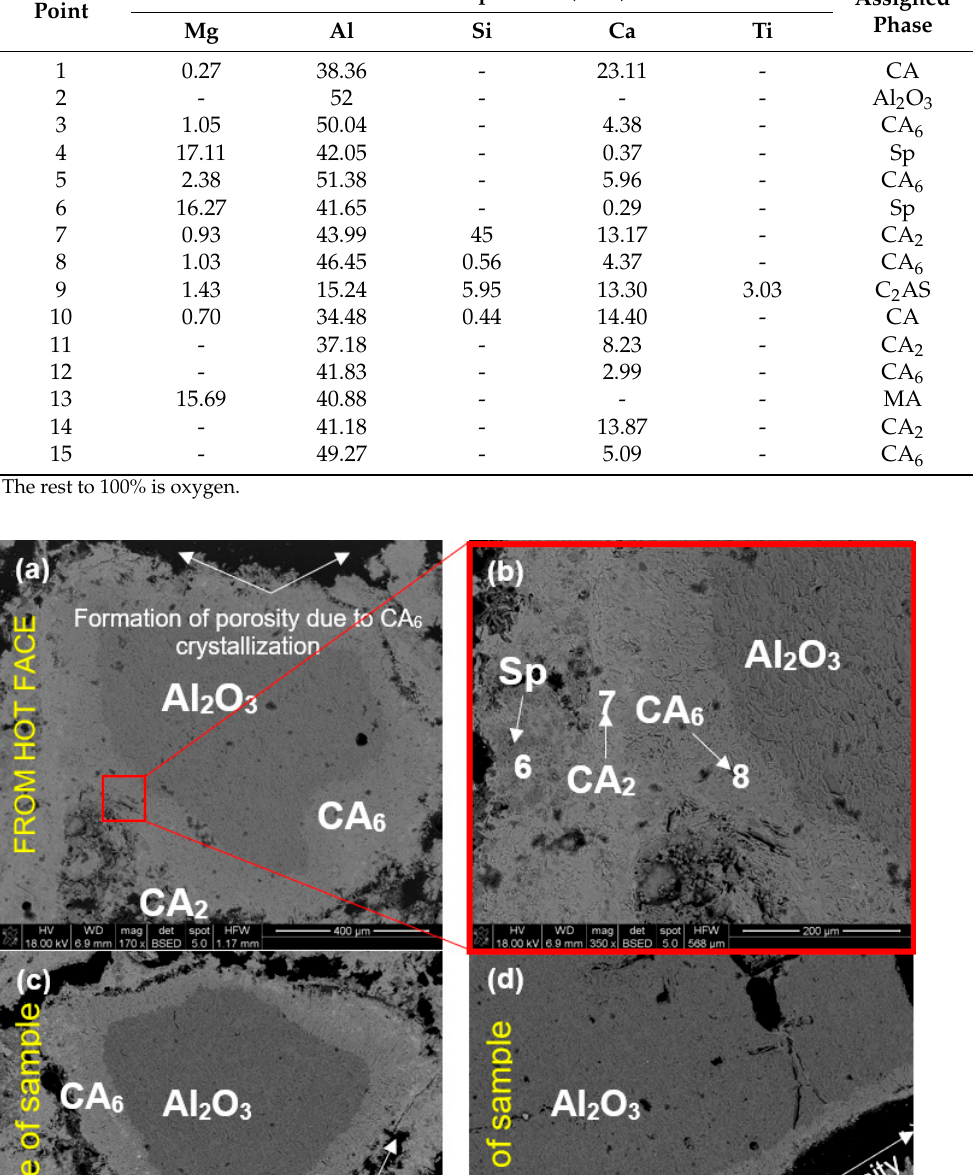
Table 6. EDS chemical composition in selected micro-areas indicated in Figures 12–15.